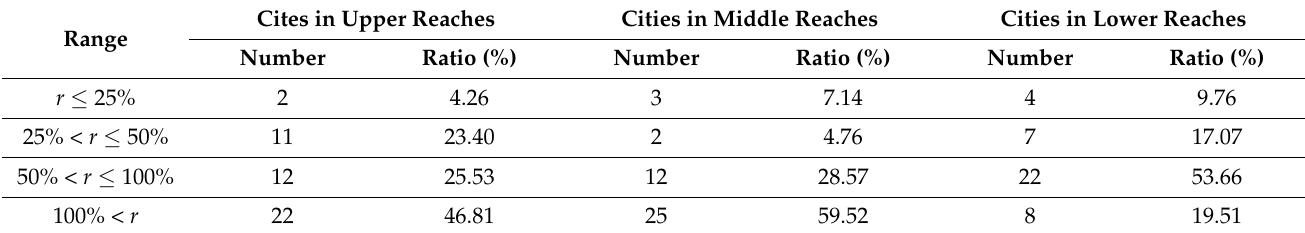
Table 4. Growth rates ( r ) of night-time light of cities in the three